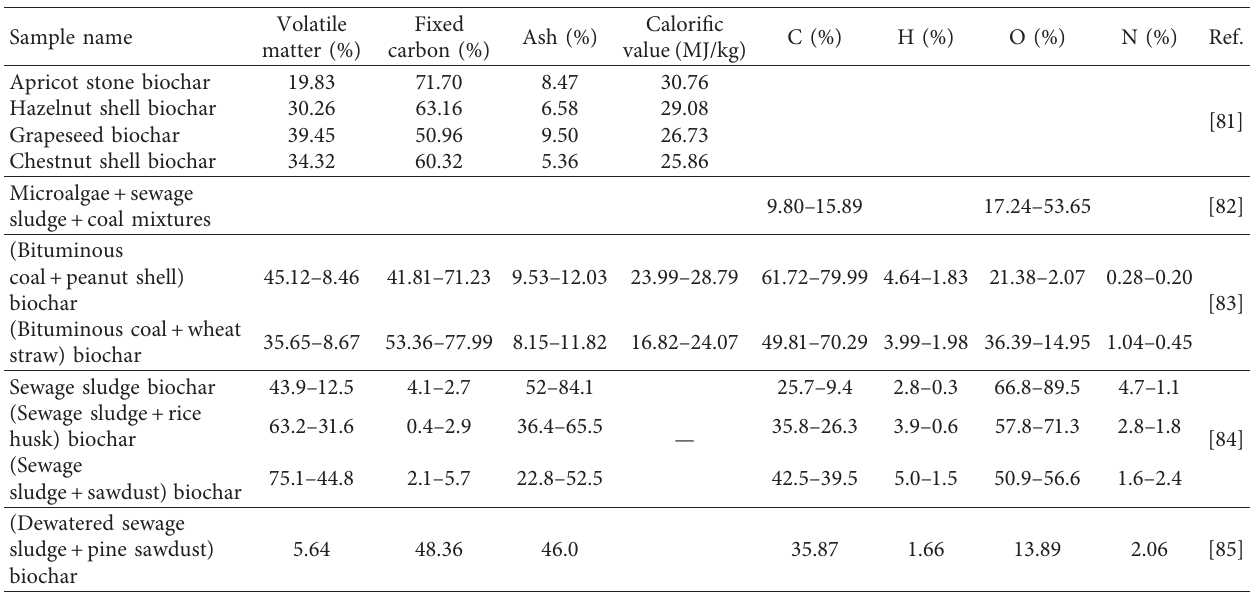
Table 3: Elemental and chemical composition of product obtained from coal, lignocellulosic biomass, sludge, and their